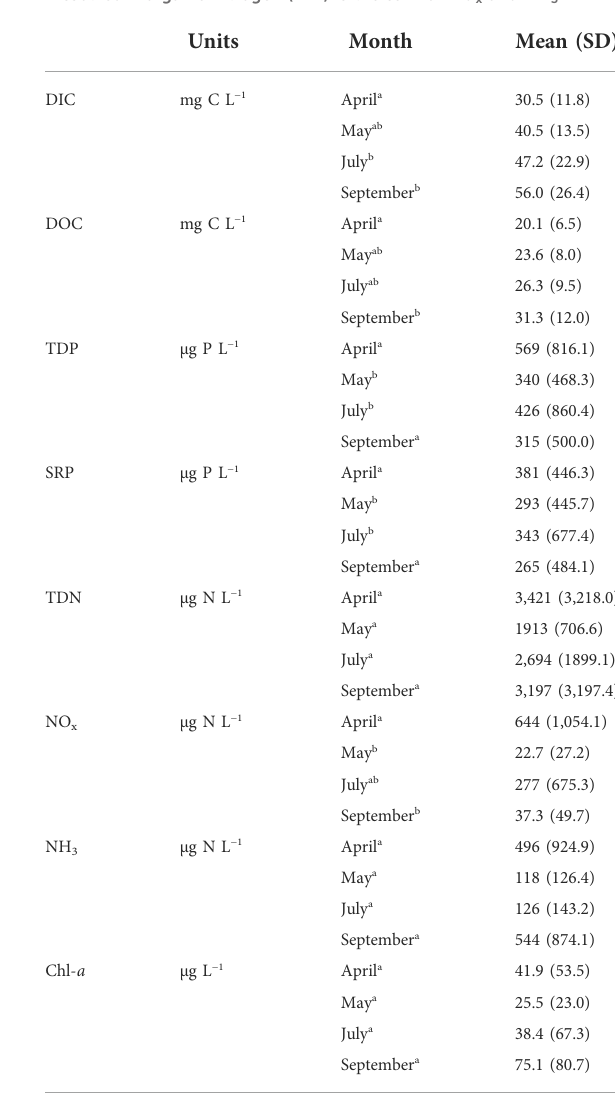
TABLE 2 Carbon and nutrient concentrations for each month in the 20 reservoirs in 2018. Presented as mean ± standard deviation (SD). Superscript letters denote signi fi cant differences based on ANOVA and post-hoc Tukey test. DIC = dissolved inorganic